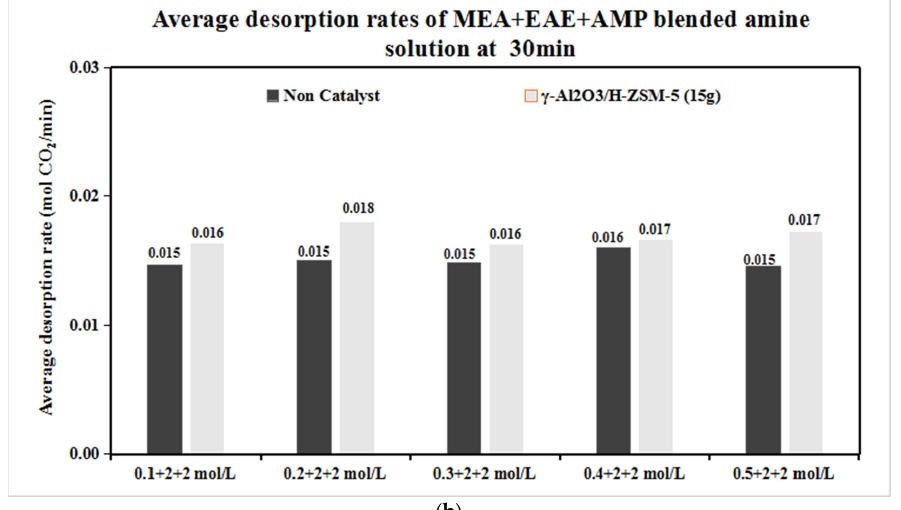
Figure 2. The average desorption rates of MEA + EAE + AMP at 0.1–0.5 + 2 + 2 mol/L with catalysts at ( a ) 15 min and ( b ) 30 min.